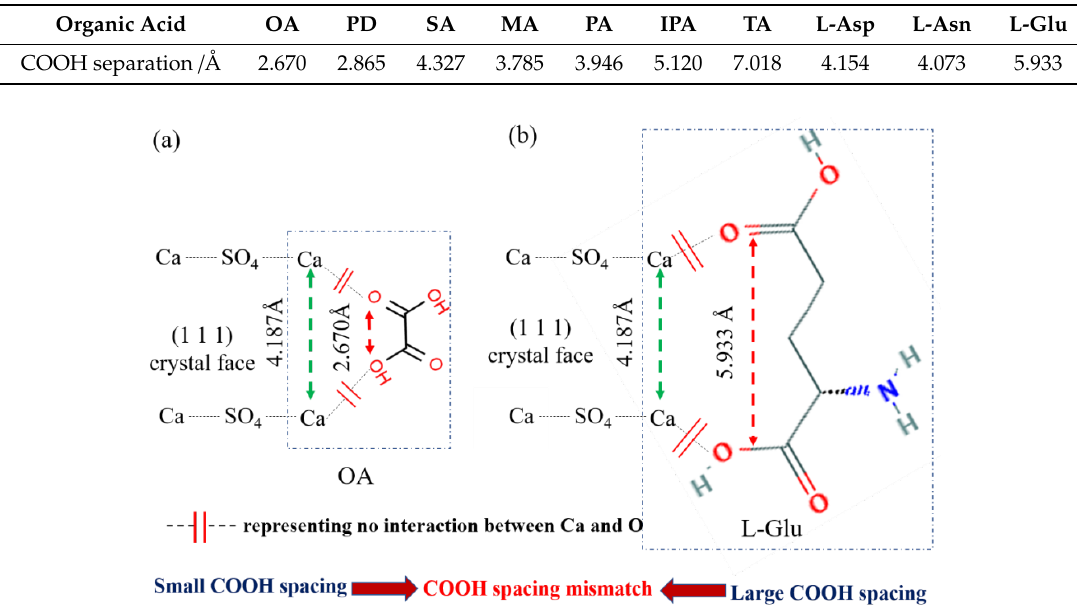
Table 4. COOH separation of different organic acids.